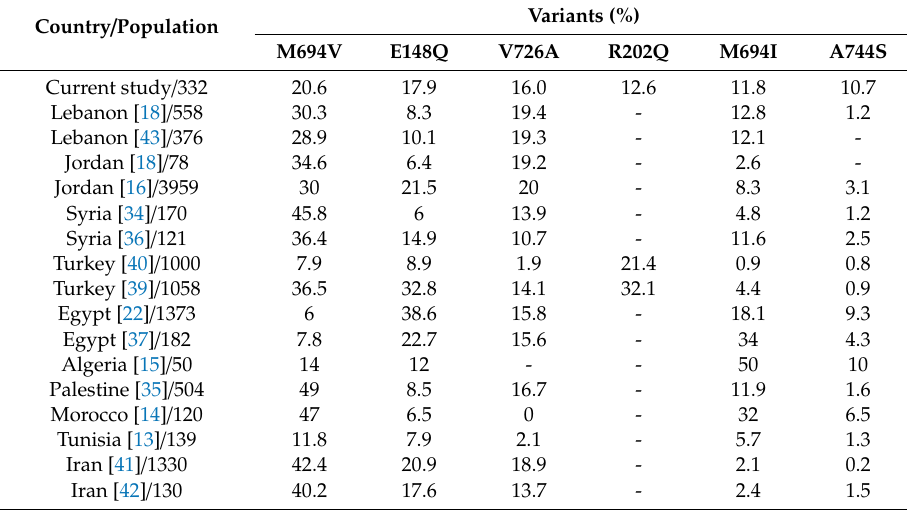
Table 5. Distribution and frequency of the six most common MEFV variants in Arab and non-Arab